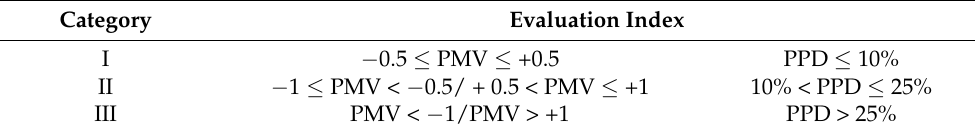
Table 5. Comfort level based on PMV – PPD.